Question: What form of chart is displayed?
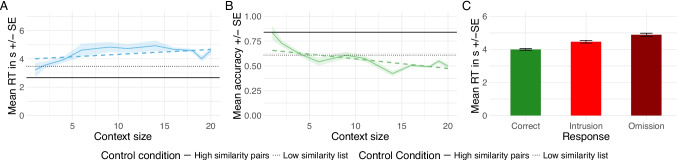
Answer: bar